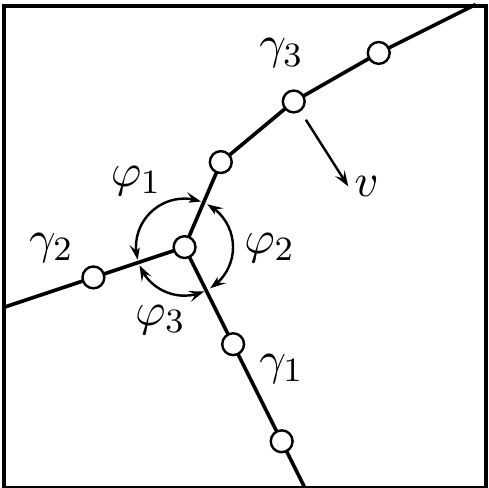
Figure 7. Vertex model representation of a triple junction between three boundaries having the interface energies γ and the separation angles ϕ . The nodes are indicated by 1 , 2 , 3 1 , 2 , 3 circles and the local velocity v of a node is